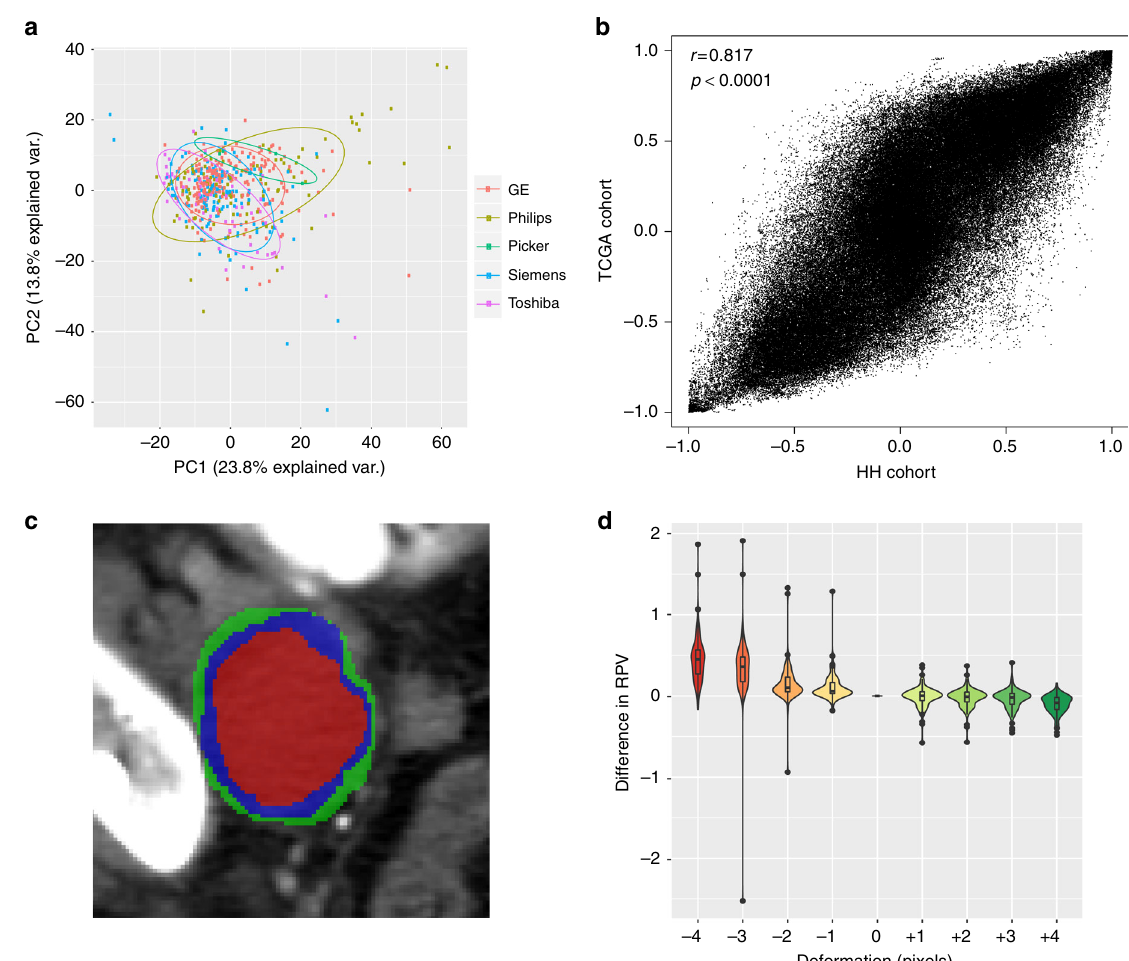
Fig. 4 The reliability and reproducibility of radiomic pro fi le. a Principal component analysis (PCA) plot of radiomic pro fi le by scanner manufacturers. b Radiomic feature-wise correlations of two independent cohorts. x -axis indicates the correlation between any two radiomic features in the HH cohort, y - axis indicates the corresponding feature-wise correlation in the TCGA cohort. The Pearson correlation coef fi cient and p value is indicated. c An illustration of erosion (red) and dilation (green) on the original segmented CT scan (blue). d Impact of segmentation deformations on RPV. x -axis indicates the range of deformations from erosion by 4 voxels ( − 4) to dilation by 4 voxels ( + 4) and 0 is the original segmentation. y -axis indicates the difference between deformed RPV and original RPV. HH Hammersmith Hospital, TCGA the Cancer Genome Atlas, CT computed tomography, RPV radiomic prognostic